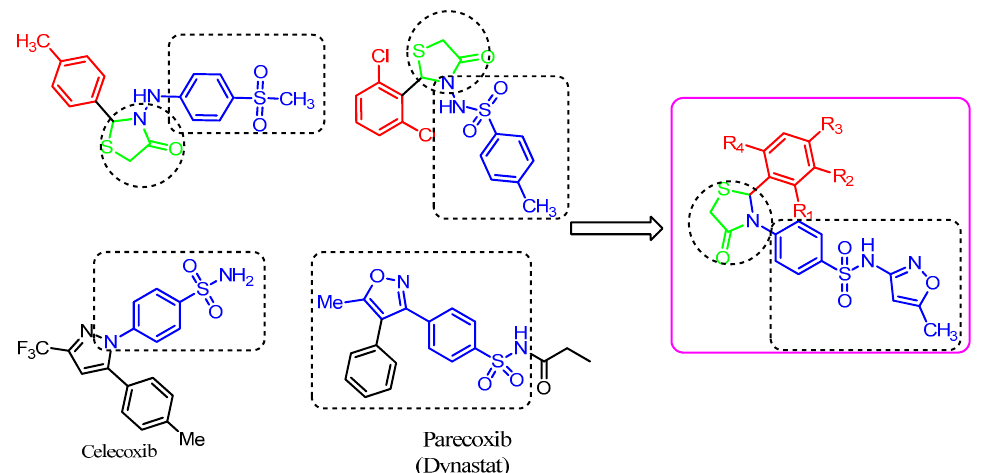
Figure 2. Molecular design of the target molecule.